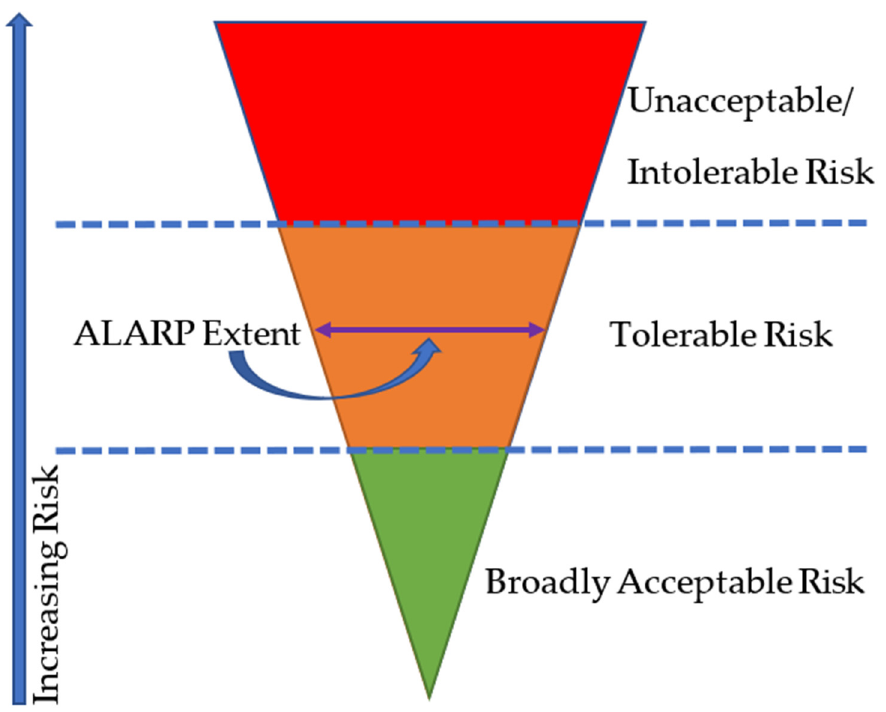
Figure 23. The ALARP Principle showing levels of tolerance to risk.